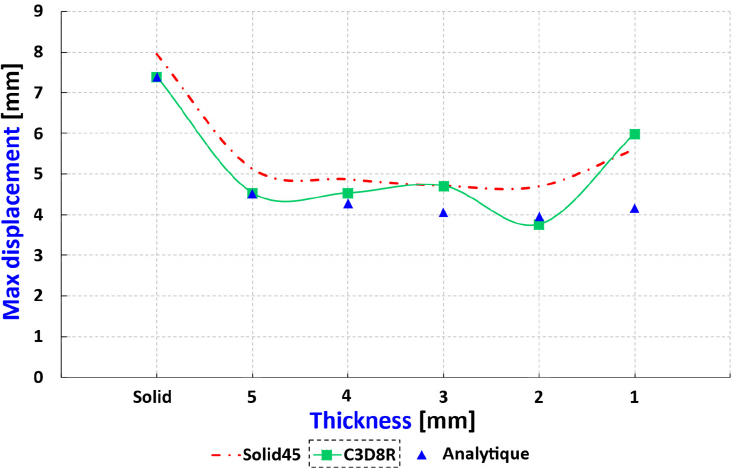
Figure 6. Comparison of maximum displacement with analytical and numerical results of saqib et al. [27]. Table 1. Comparison of maximum displacements as a function of different thickness values from analytics, Ansys, Abaqus, and their relative